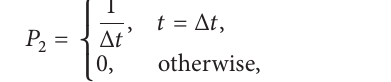
Figure 3: The displacement-time response to the second degree of freedom of 2D